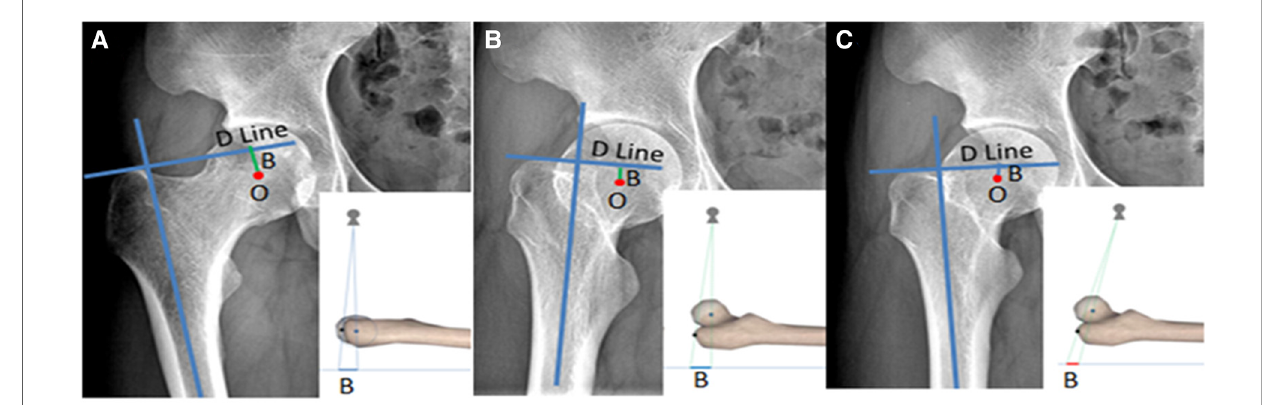
FIGURE 7 Bilateral hip x-ray of the same volunteer: ( A ) is the standard photographic method as previously mentioned, ( B ) is the externally rotated hip and the projection point is standard, and ( C ) is the externally rotated hip and the projection point is 10 cm below the midpoint of the bilateral hips; the femoral head center is signi fi cantly higher than the actual value shown in ( A